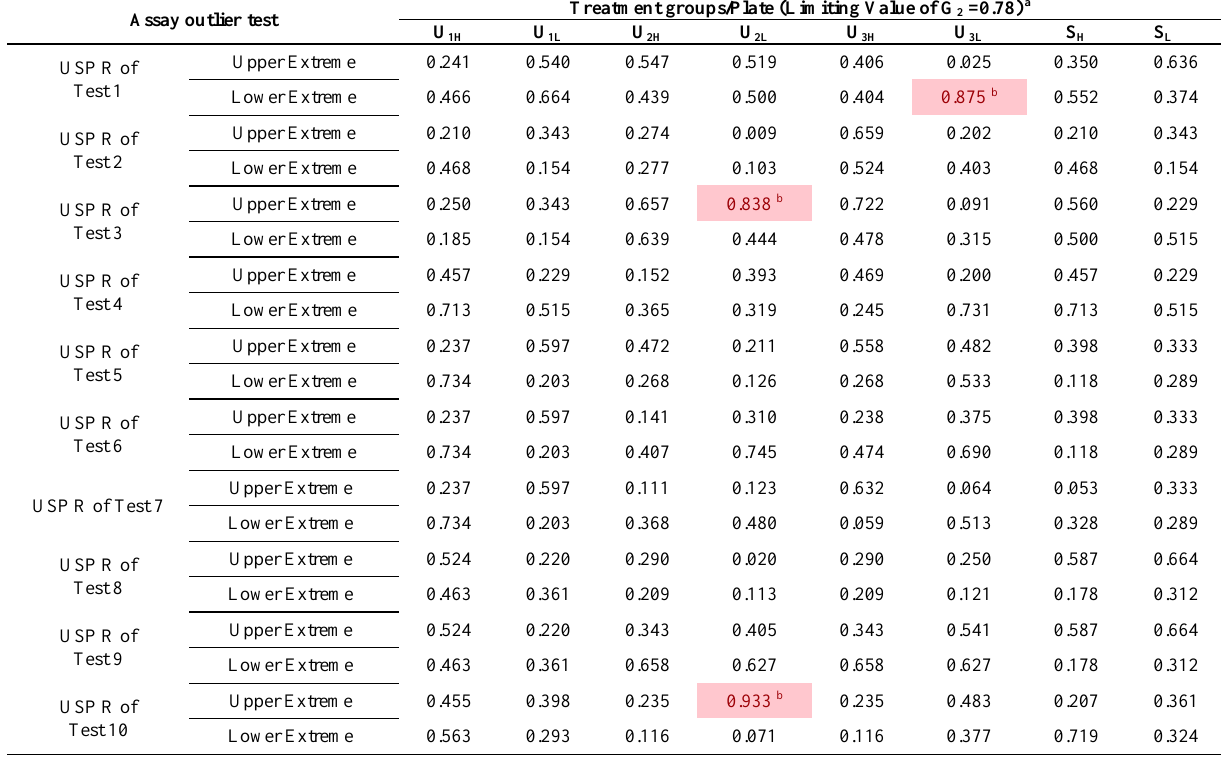
Table 1. Outlier detection in dataset using USP method